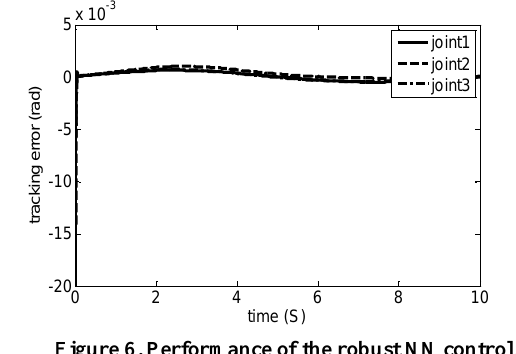
Figure 6. Performance of the robust NN control.